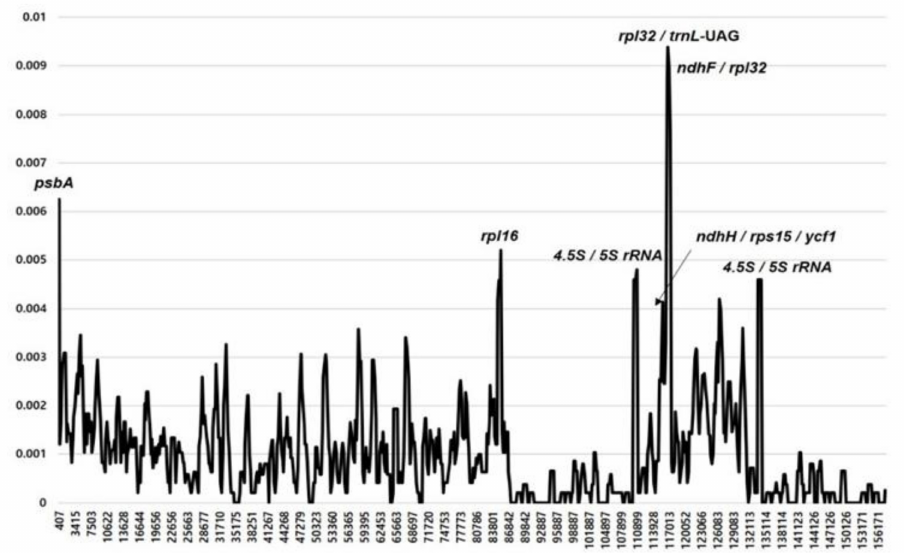
Figure 4. Sliding window analysis of the 12 whole chloroplast genomes of Hosta species. X-axis: position of the window midpoint, Y-axis: nucleotide diversity within each window.